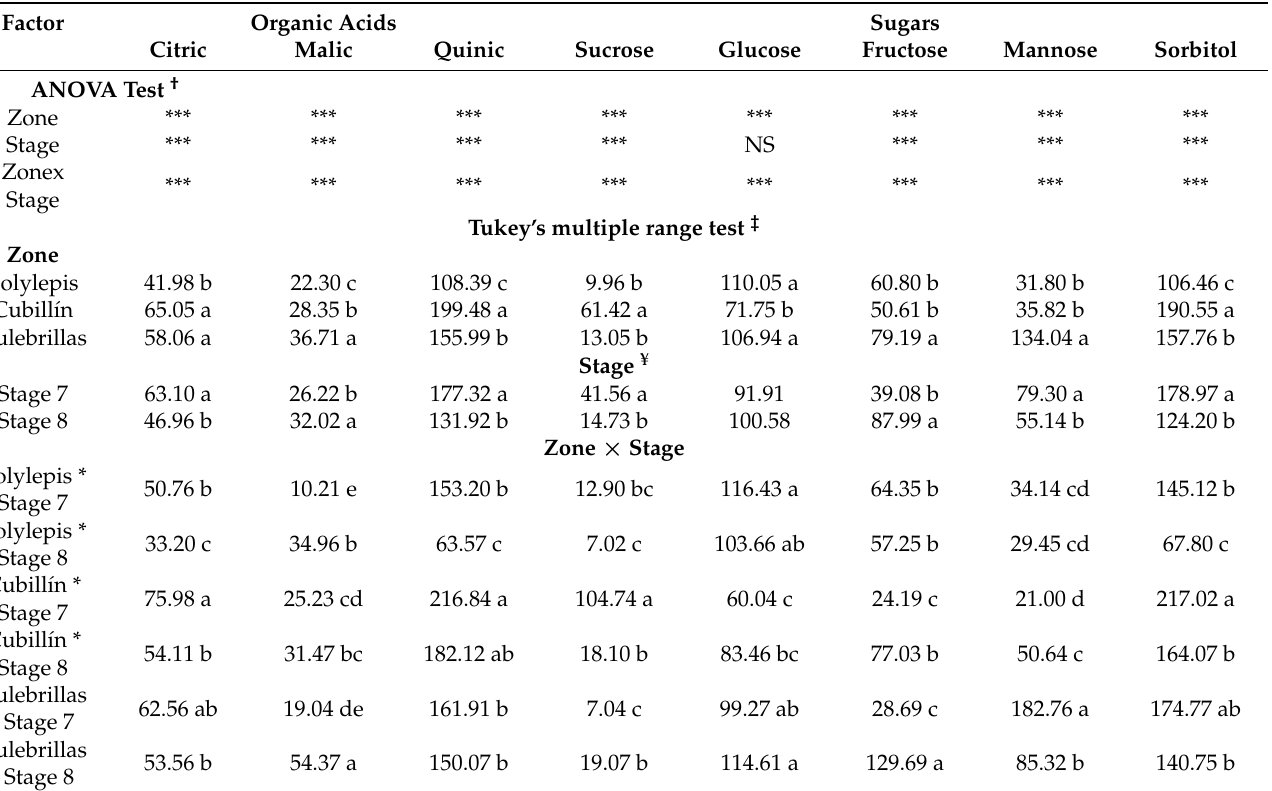
Table 3. Organic acids and sugar content (g kg − 1 dry matter, DM) in Mortiño berries as affected by location and stage of fruit